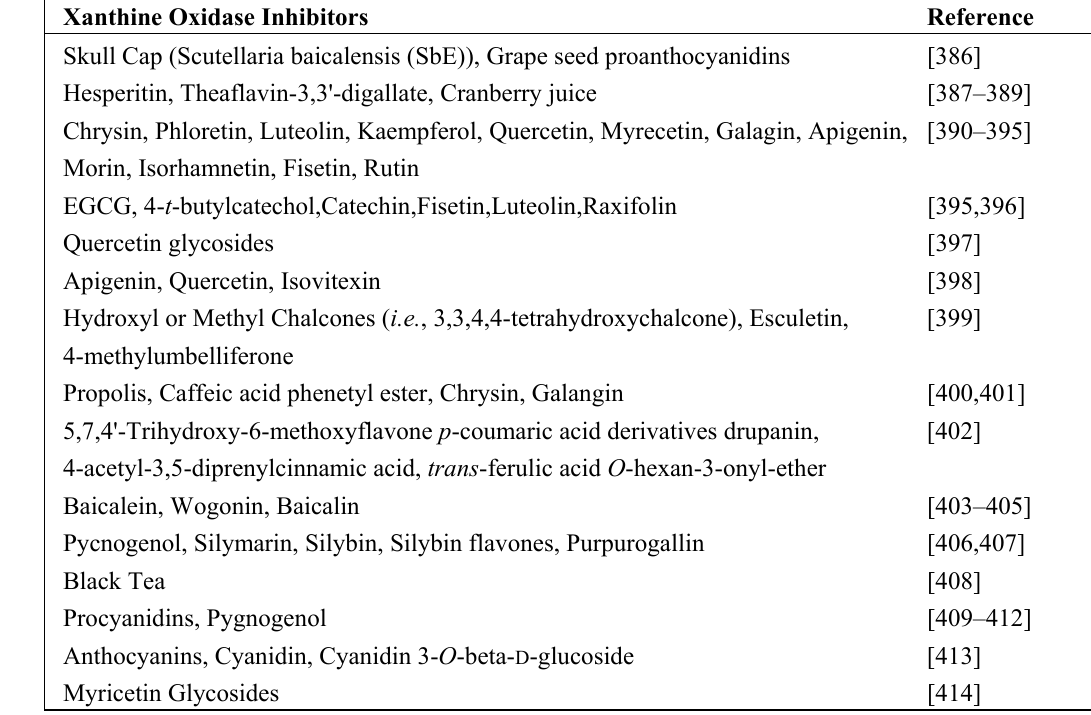
Table 4. Phospholipase A